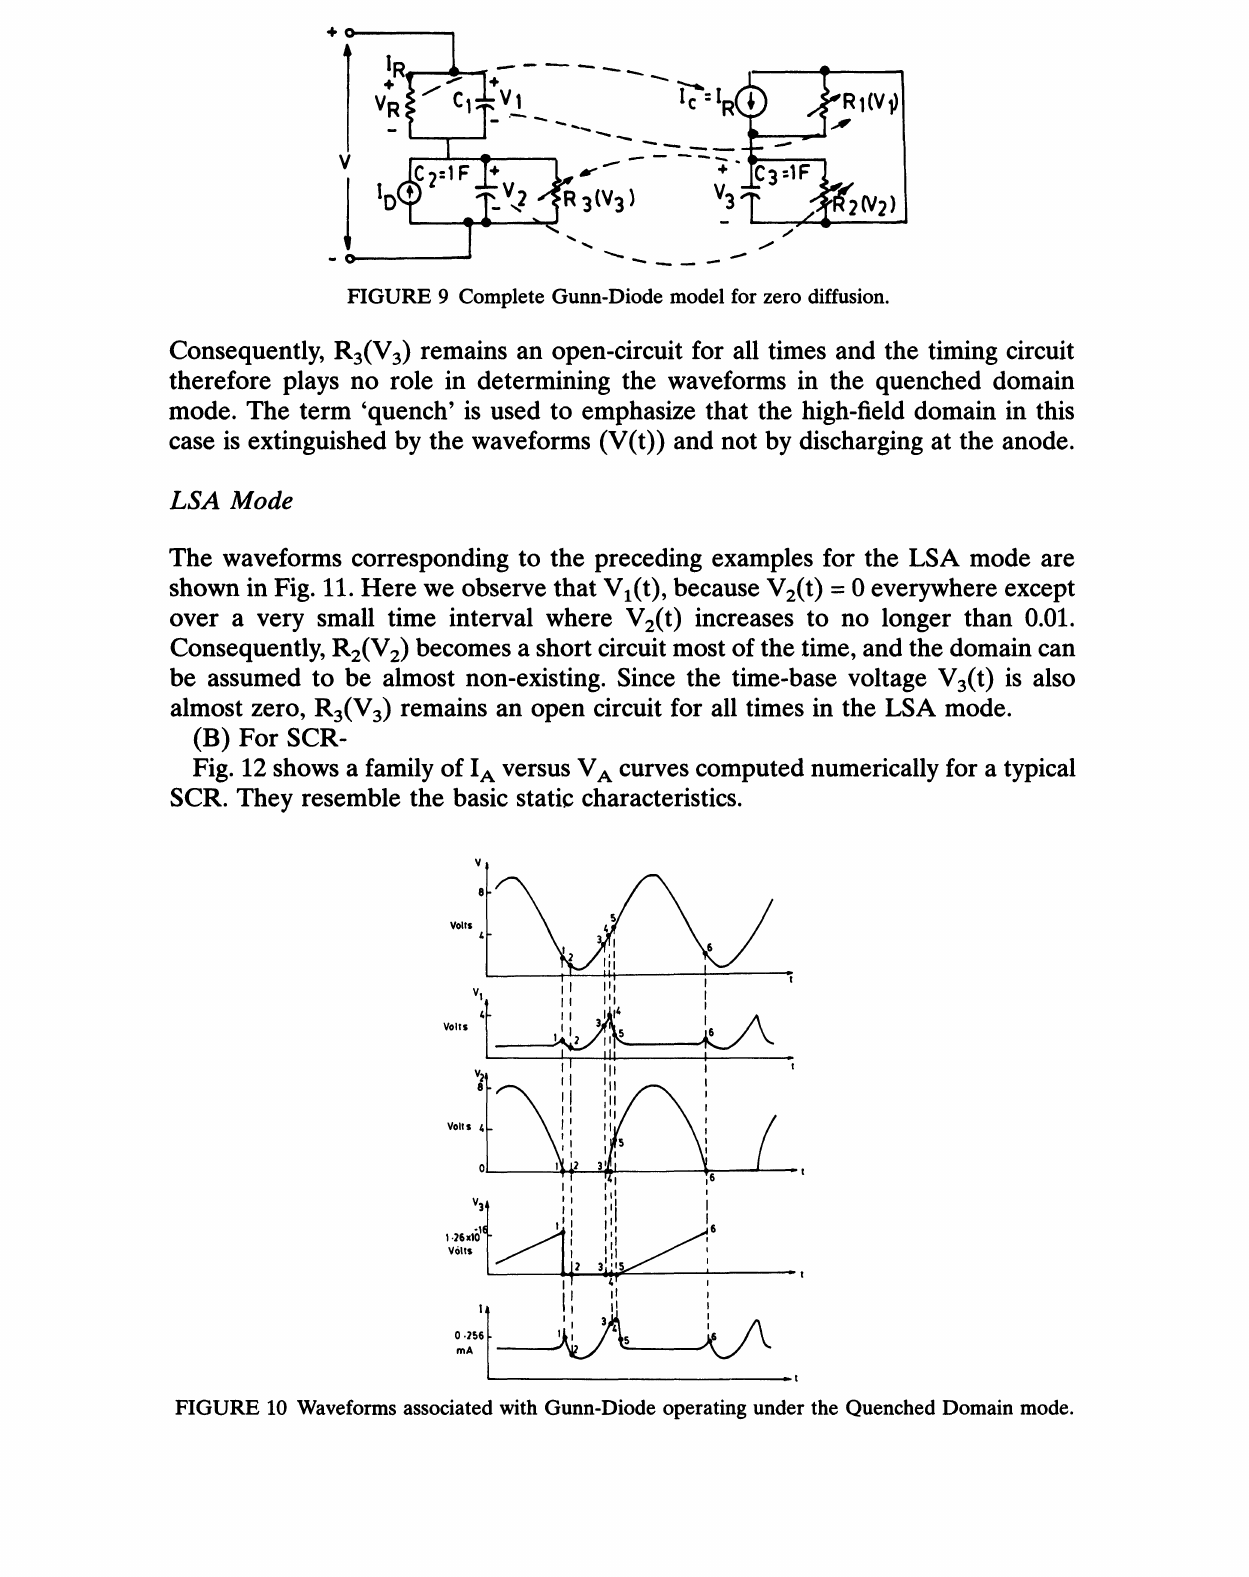
FIGURE 10 Waveforms associated with Gunn-Diode operating under the Quenched Domain